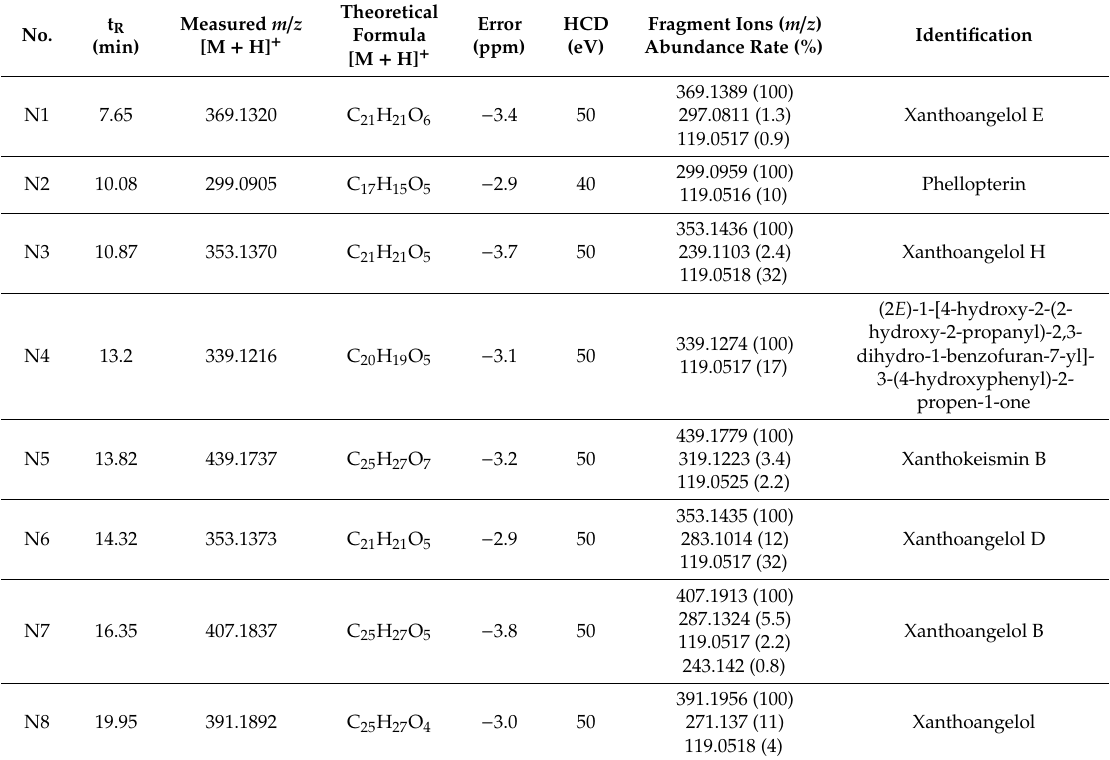
Table 2. Identification of the di ff erent amount of compounds from A. keiskei between the blank and test groups by UPLC-MS / MS in negative ion